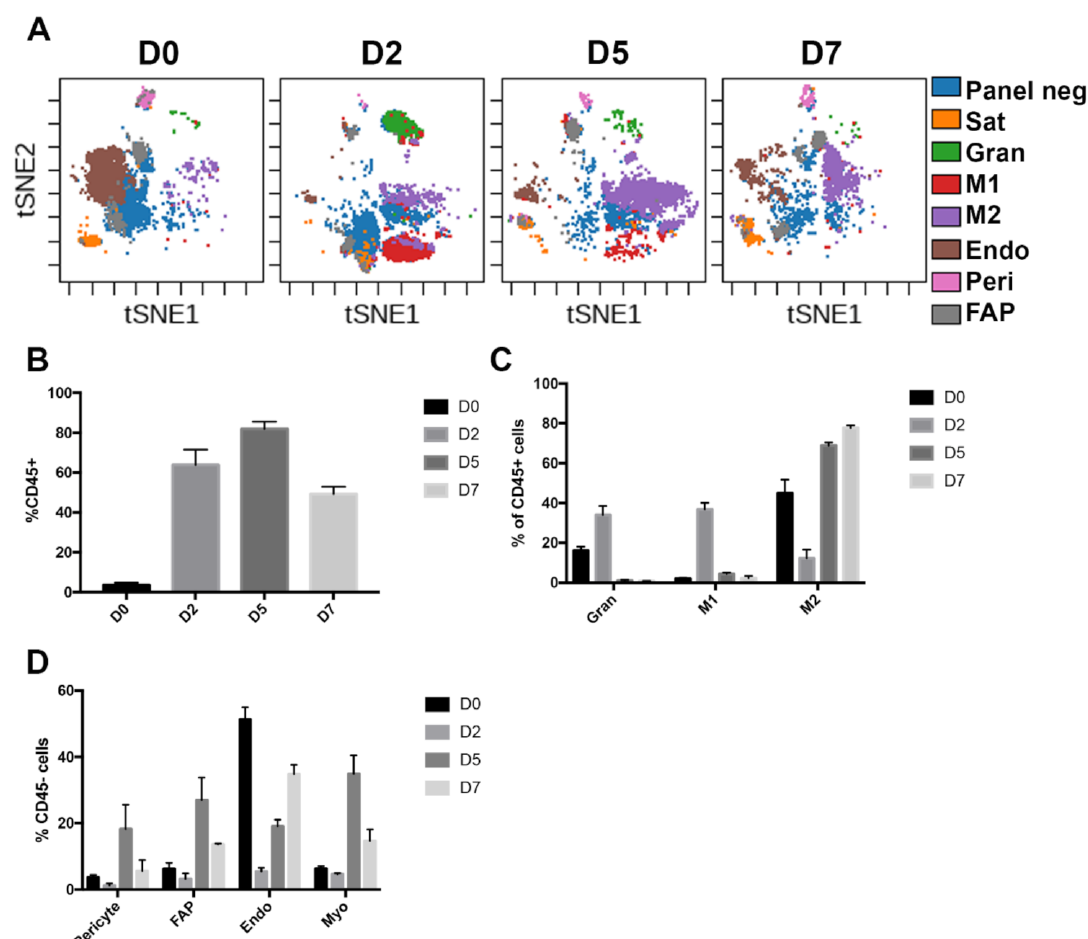
Figure 2. The cellular makeup of skeletal muscle is reshuffled following injury. ( A ) viSNE plot of regenerating TA muscle cell types before and following BaCl2 injury. Panelneg: cells not captured by manual gating of standard skeletal muscle cell markers, Myo: myogenic cells (Pax7-nGFP+), Endo: endothelial cells (CD31+), Peri: pericytes (PDGFR β + SCA1 − ), M1: type 1 macrophages (F4/80+ LY6C+), M2: type 2 macrophages (F4/80+ LY6C − ), FAP: fibro-adipogenic progenitors (PDGFR α + SCA1+), Gran: granulocytes (LY6G+). n = 3 for D0, D2, D5, n = 2 for D7. ( B ) Quantitation of immune cell proportion in resting and regenerating muscle. ( C ) Makeup of the immune compartment at different time points. ( D ) Makeup of the non-immune compartment at different time